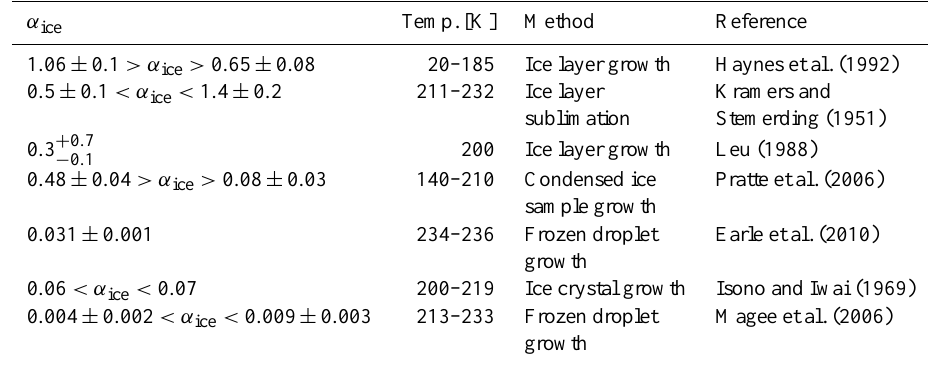
Table 1. Selection of laboratory measurements of the accommodation coefficient α ice at temperatures relevant for cirrus clouds. Results are spread over almost three orders of magnitude. Previous studies are summarized in Choularton and Latham (1977), Haynes et al. (1992), and Pruppacher and Klett